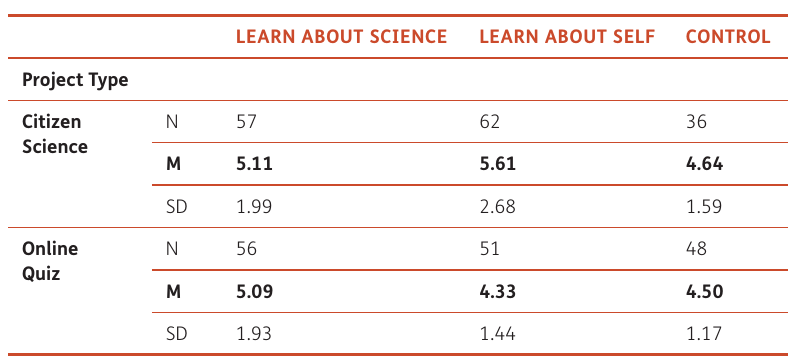
Table 1 Mean disclosed Sensitive Items ( bold ) across Project Type groups.